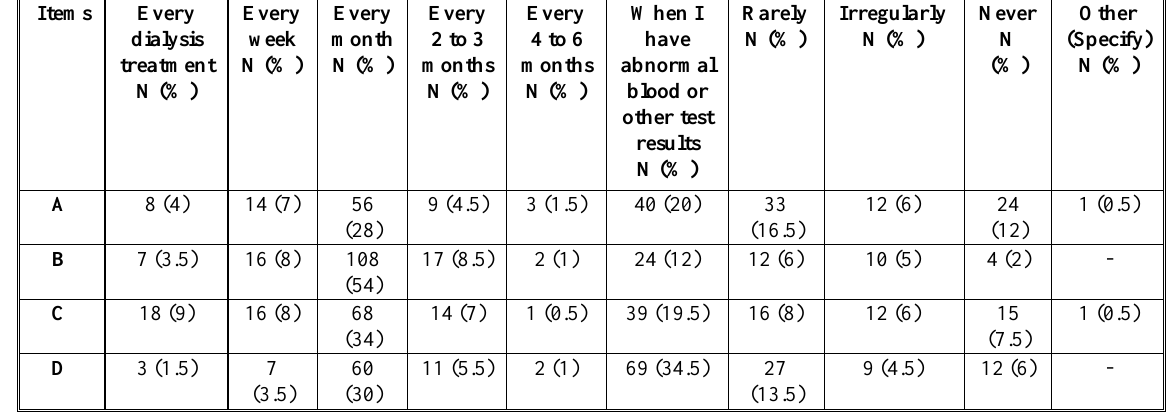
Table 6. Frequency of counseling received by patients for different treatment